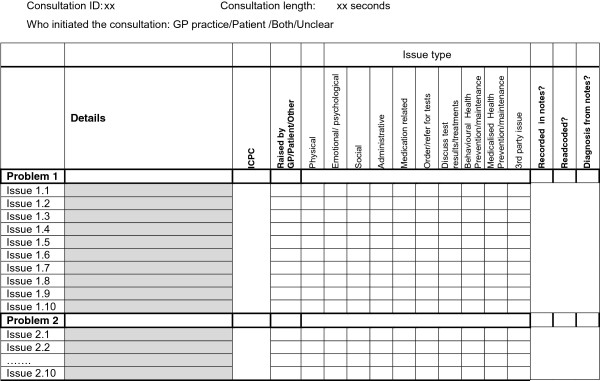
Coding proforma.